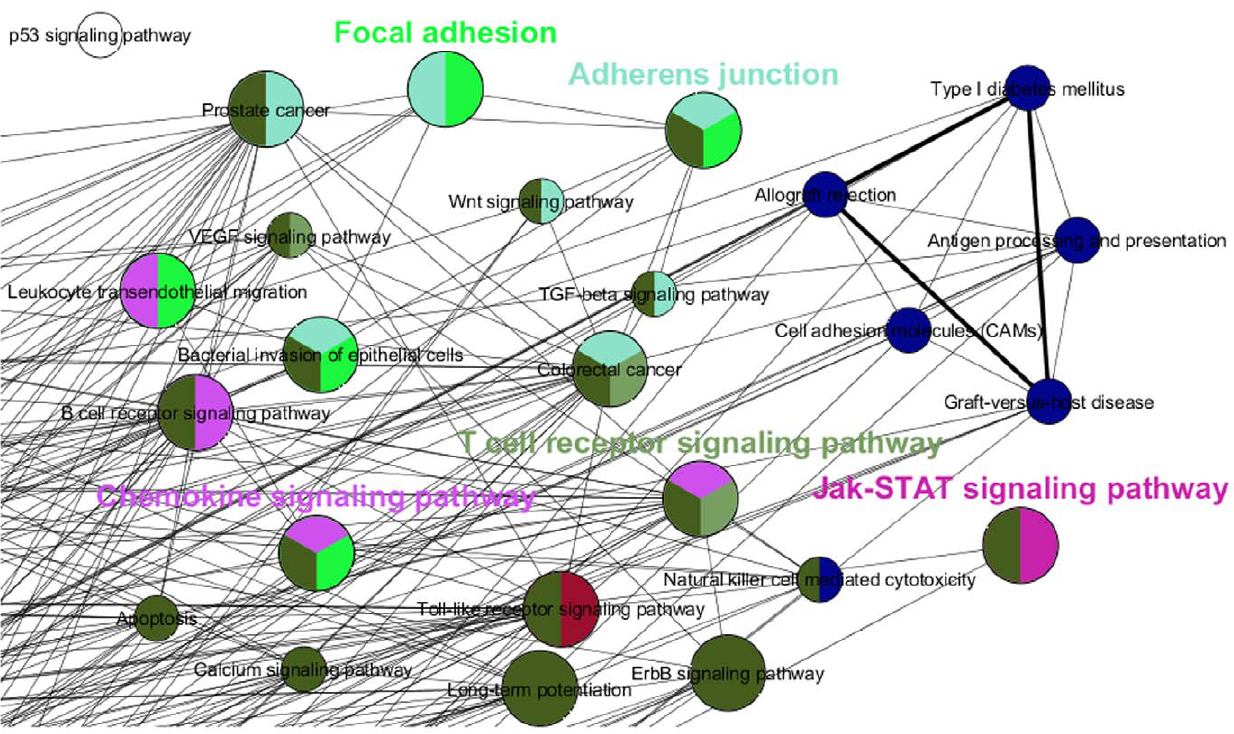
Figure 6. Comparison of KEGG pathway terms with literature verified RA genes/our gene set were shown in green/red, respectively. Nodes represent the identified pathway terms from any one of the two sets. The color gradient showed the gene proportion of each set associated with the term. White color represented equal proportions from the two comparison sets. The size of the nodes reflected the statistical significance of the terms (term p-values corrected with Bonferroni). Following the convention in Figure 4, edges represented the existence of the shared genes between the pathway terms and node border colors mapped to the group colors. Zoomed in view of panel a is shown in panel b.